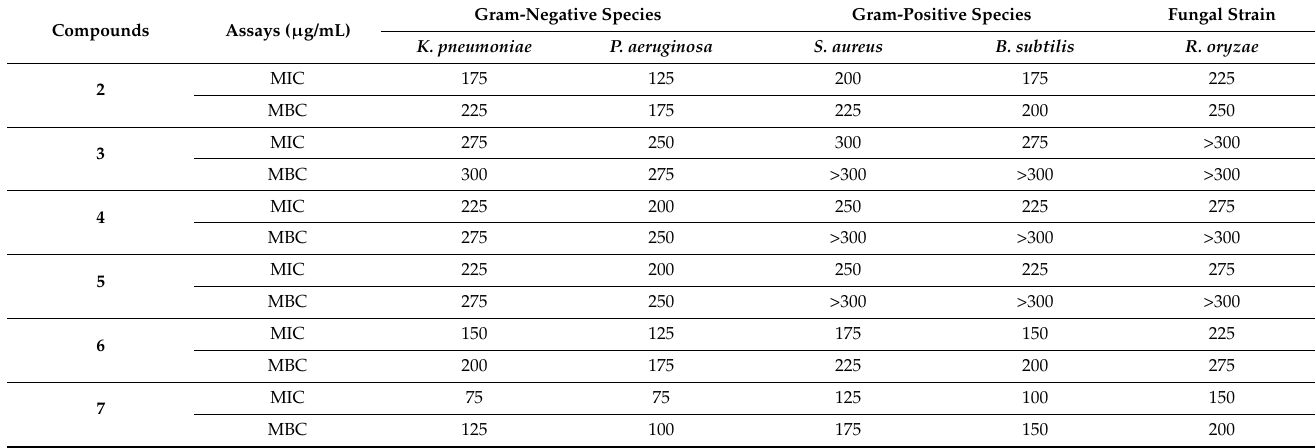
Table 2. Minimum inhibitory concentrations (MICs) and minimum bactericidal concentrations (MBCs) of studied newly synthesized compounds against microbial